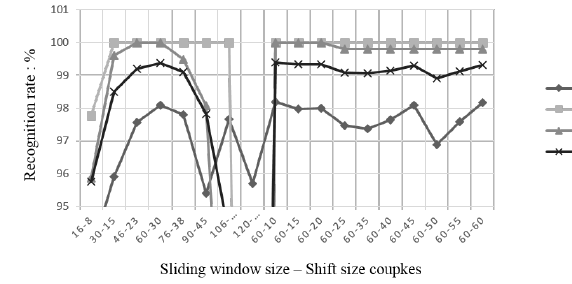
Fig. 3. Recognition rate for several window-shift couples